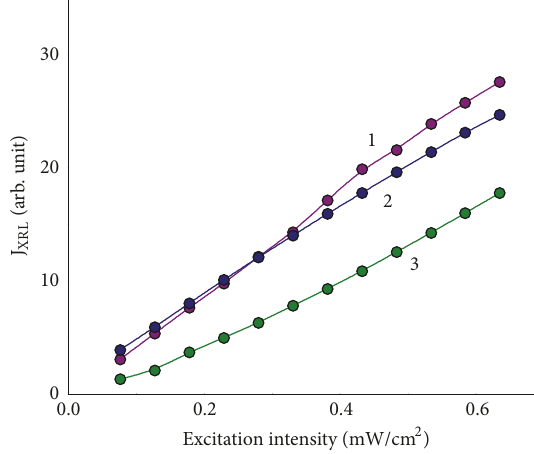
Figure 6: Lux-ampere characteristics of XRL of the ZnSe sample at the irradiation wavelength of 970 nm under the temperatures: 8 K (1) , 85 K (2) , and 295 K (3) .